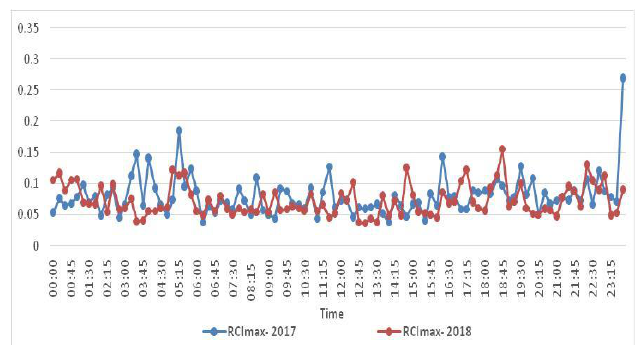
Figure 20. Comparison between RCI for maximum values of downward power ramps in 15 min interval at each observation time t for the years 2017 and 2018.